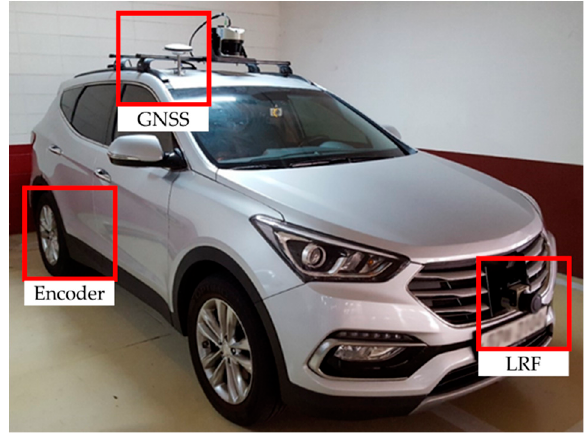
Figure 3. Experimental platform: Santa Fe DM 2.0 2WD with an Autonics E40HB wheel encoder, Novatel Propak-V3, and SICK LMS111. Note: GNSS = global navigation satellite system; LRF = laser range finder.